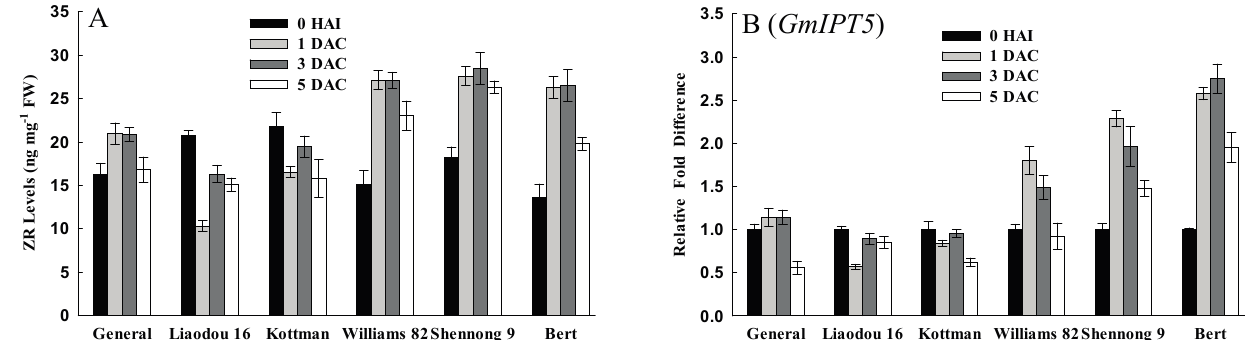
Figure 4. Comparison of zeatin riboside (ZR) levels and the expression levels of ZR synthetic gene between different genotypes. The values represent means ± SD based on three biological replications. ( A ) ZR content in cotyledonary nodes after 0 h of infection, and after one day, three days, and five days of co-cultivation; ( B ) qRT-PCR analysis of ZR synthetic gene GmIPT5 .